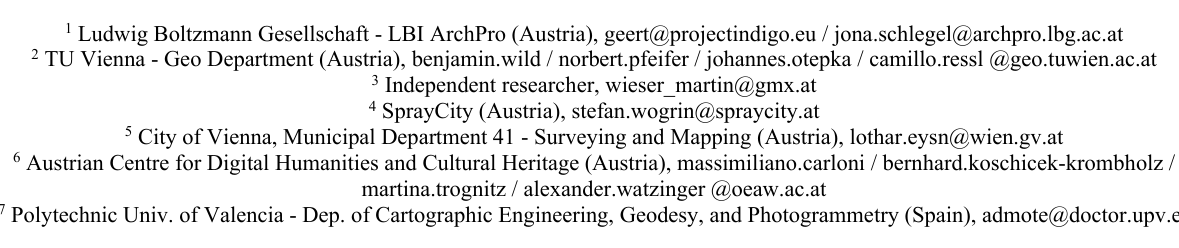
from colourful murals, anarchistic symbols on bridge pillars to bike stand writings (Figure 1).